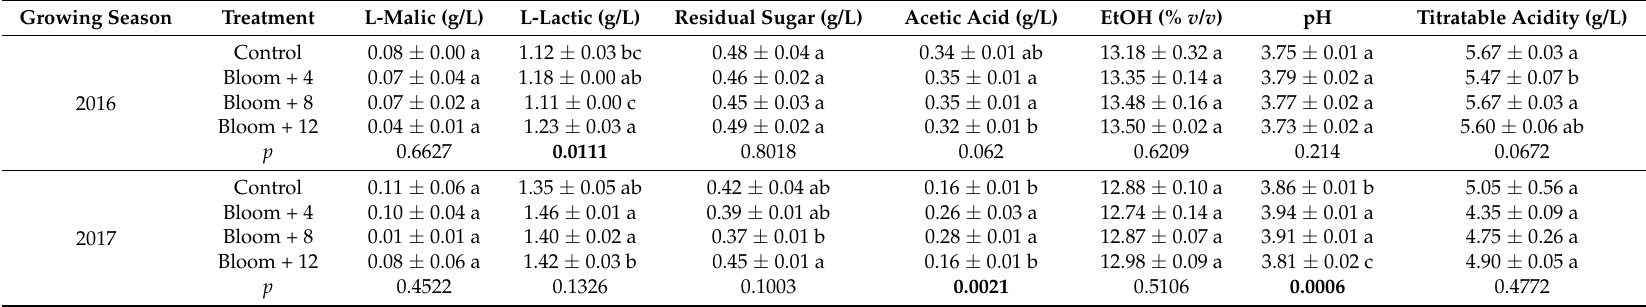
Table A4. Wine chemical composition post-malolactic fermentation by treatment and growing season. Treatment means followed by standard error of the mean. Different letters within a column and growing season indicate significant differences between treatment groups for Fisher’s LSD at p < 0.05. p values below 0.05 are shown in bold fonts.